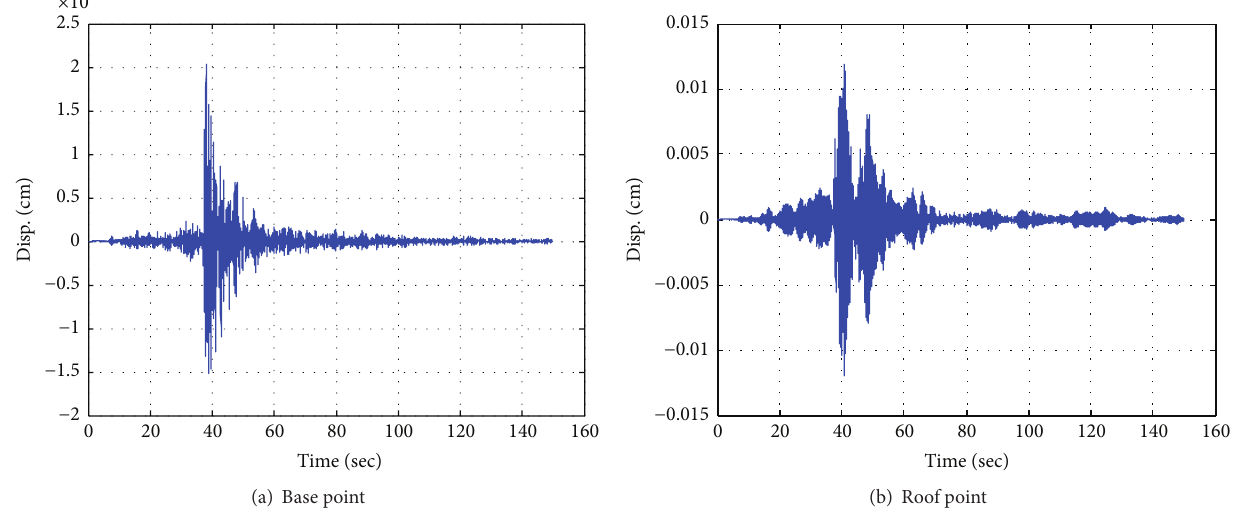
Figure 9: Dynamic displacement in 𝑋 direction during the earthquake